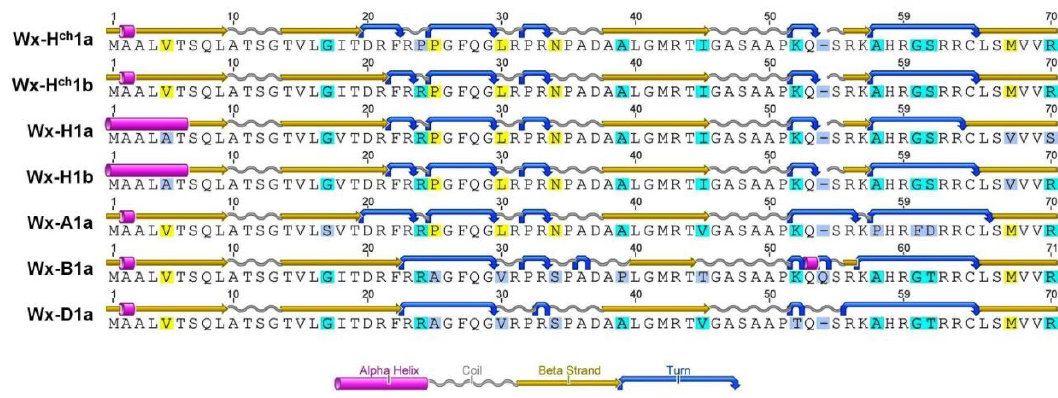
Figure 2. Comparison of the secondary structure motifs predicted by Garnier for the transit peptide region among all sequences evaluated.